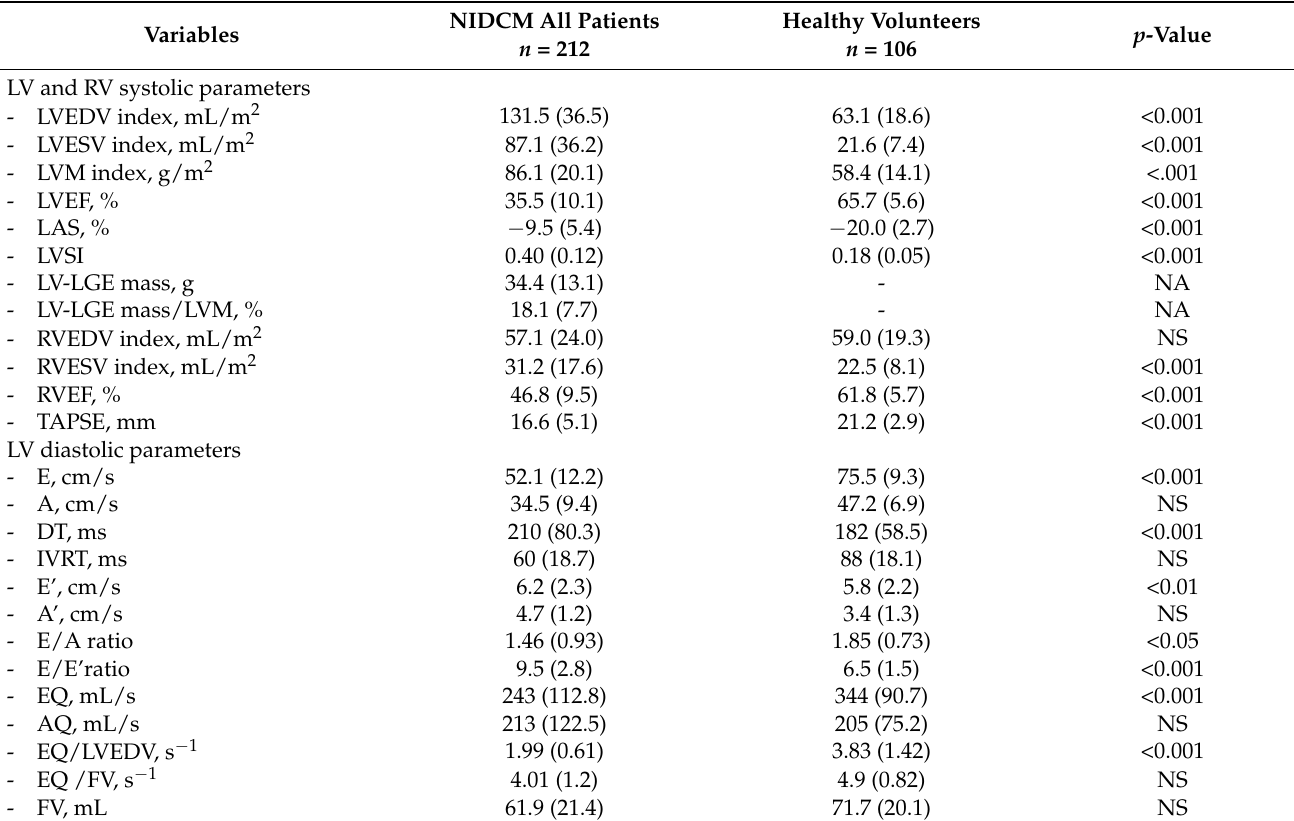
Table 2. Cardiac magnetic resonance imaging indices of systolic and diastolic